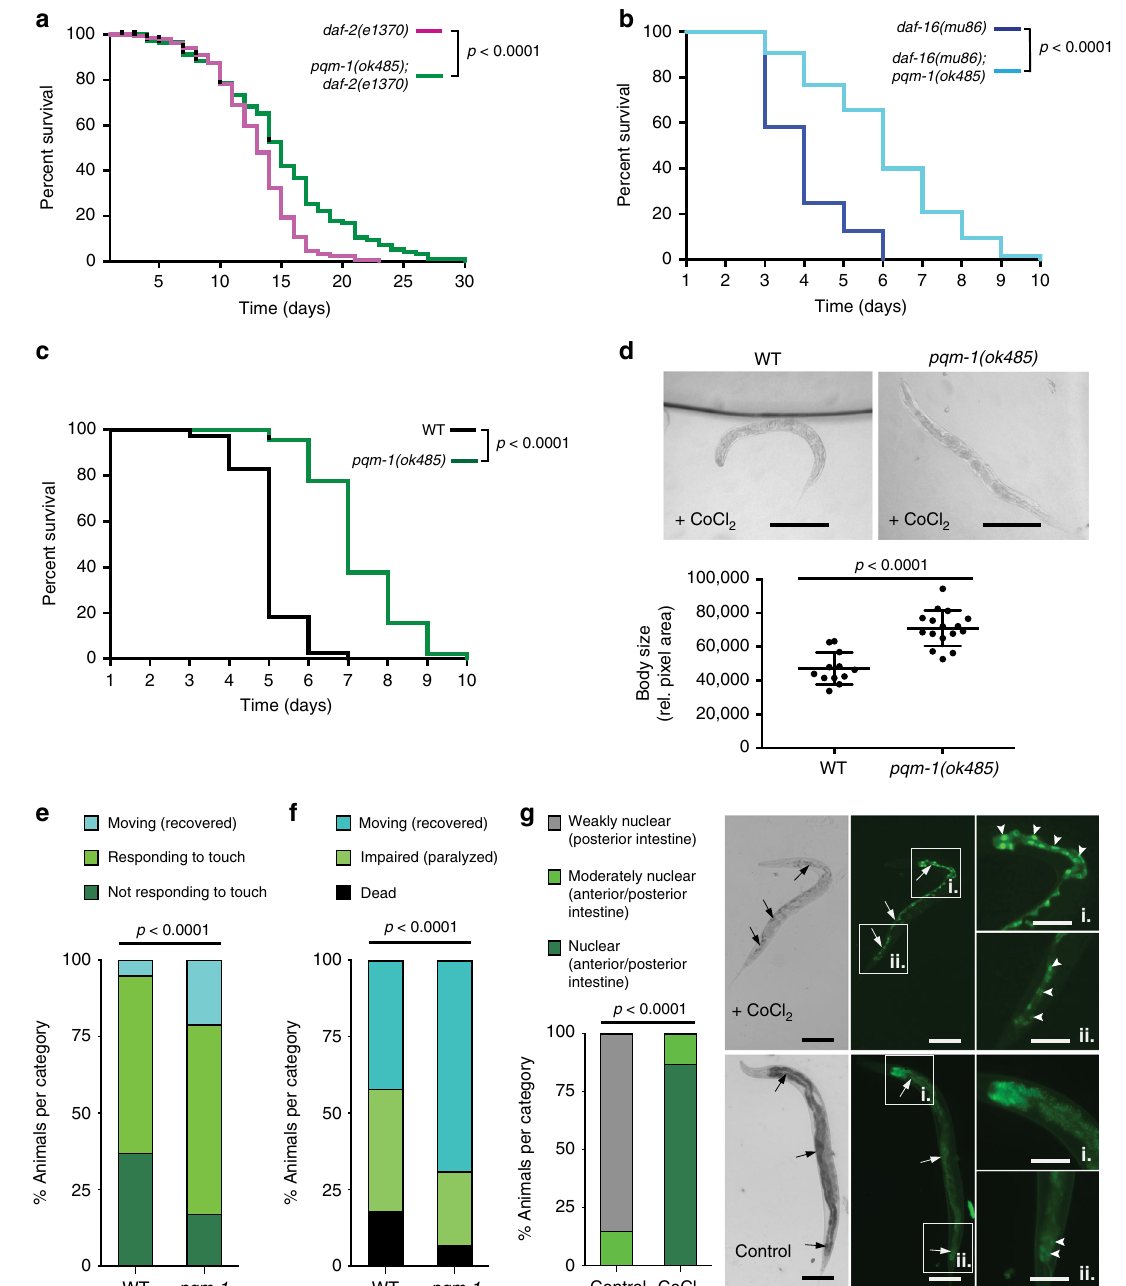
Fig. 1 Loss of pqm-1 increases survival and recovery under hypoxic conditions. a – c Survival analysis of animals exposed to 5 mM CoCl 2 at the L4 larval stage. a daf-2(e1370) ( n = 130), pqm-1(ok485);daf-2(e1370) ( n = 99). b daf-16(mu86) ( n = 51), daf-16(mu86);pqm-1(ok485) ( n = 63). c WT (N2) ( n = 70), pqm-1(ok485) ( n = 45). Log-rank analysis (two-sided) ( a – c ). Three ( a , b ) and four ( c ) independent experiments were performed. d Shrinking of worms exposed to 5 mM CoCl 2 at the L4 larval stage for 3 days and quanti fi cation of body size. Two-tailed t -test, mean ± SD, WT (N2) ( n = 12), pqm-1(ok485) ( n = 16); scale bars: 200 µ m. Three independent experiments were performed. e Measurement of touch response of animals after exposure to <0.3% O hypoxic chamber for 16 h at 26 °C followed by an 8 h recovery period; WT (N2) ( n = 156), pqm-1(ok485) ( n = 196). f Survival analysis of animals after exposure to <0.3% O 2 in a hypoxic chamber for 16 h at 26 °C followed by a one-day recovery period; WT (N2) ( n = 137), pqm-1(ok485) ( n = 162). e , f Chi- square analysis was performed, three independent experiments. g Nuclear localization analysis of a PQM-1::GFP fusion protein expressed in the intestine of worms exposed to 5 mM CoCl 2 at the late L4 larval stage for 20 h until worms reach the adulthood stage. Arrows point to intestine; arrowheads point to intestinal nuclei in insets. Insets display anterior (i.) and posterior (ii.) intestinal regions. Representative images for the category “ nuclear in anterior and posterior intestine ” are displayed (CoCl 2 condition, top). The category “ weakly nuclear in posterior intestine ” is represented by the control condition (bottom); scale bars: 100 µ m, in insets: 50 µ m. Chi-square analysis was performed; control condition ( n = 54), CoCl 2 condition ( n = 30); three independent